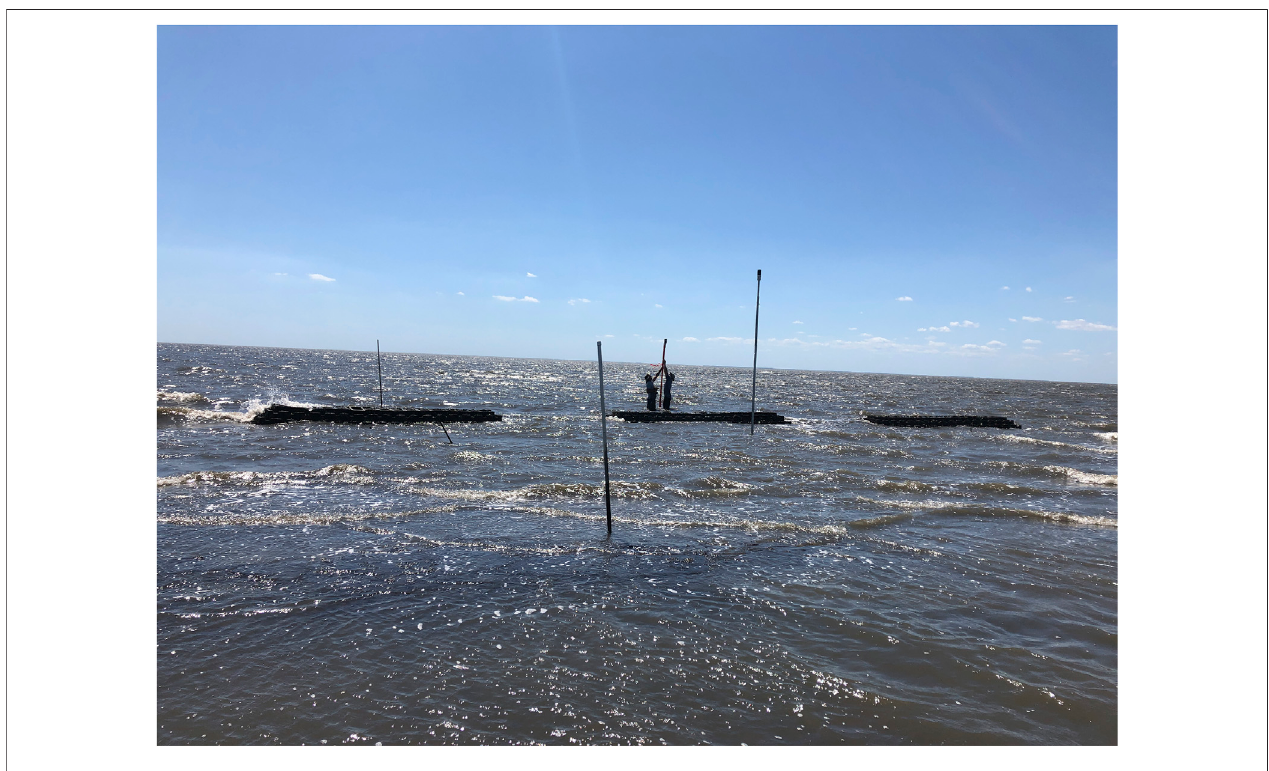
FIGURE 2 | Photograph of Oyster Castle ® breakwaters, August 2019.